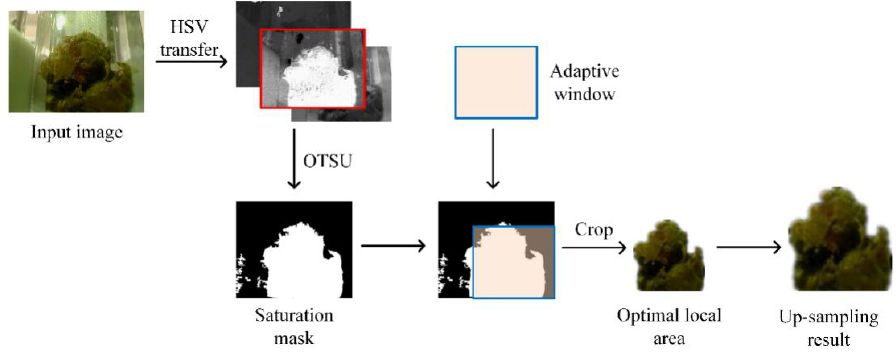
Figure 4. Adaptive upsampling of ROI.